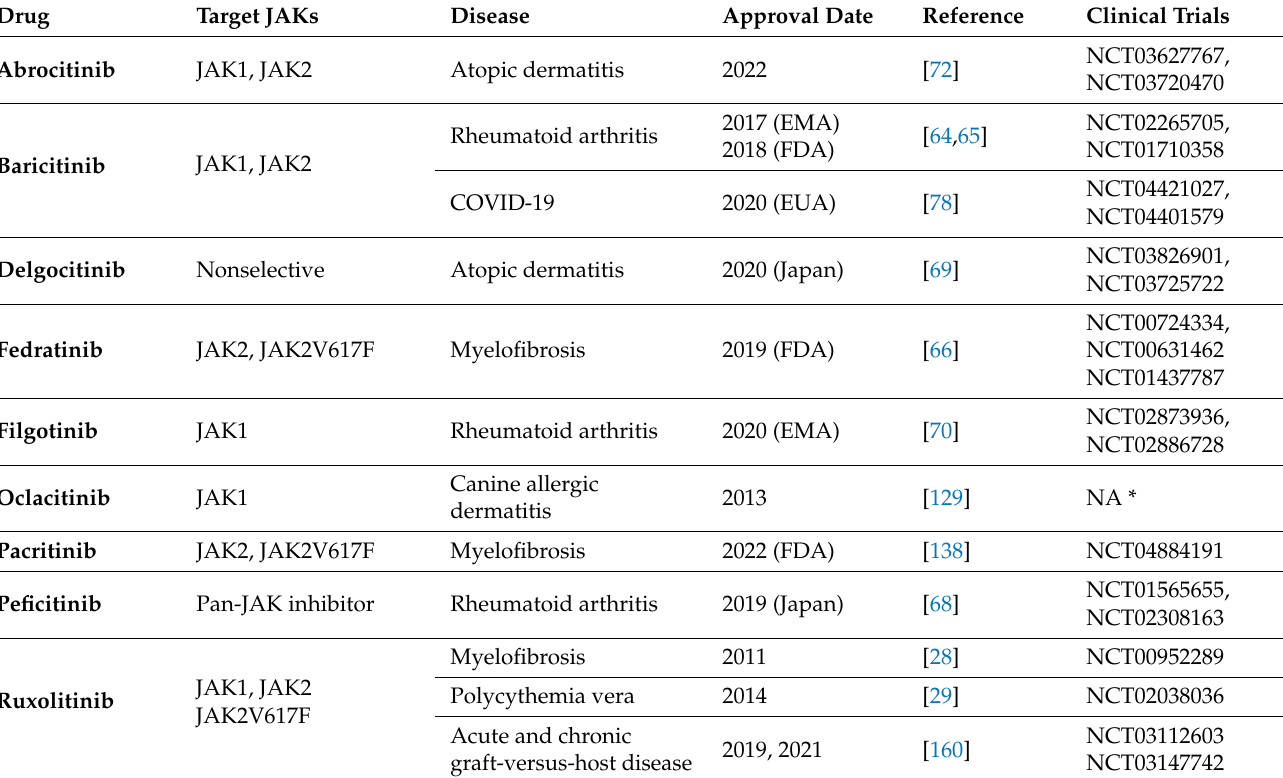
Table 1. The globally approved JAK inhibitors, their target kinase, clinical trials, and the approval data. Drug Target JAKs